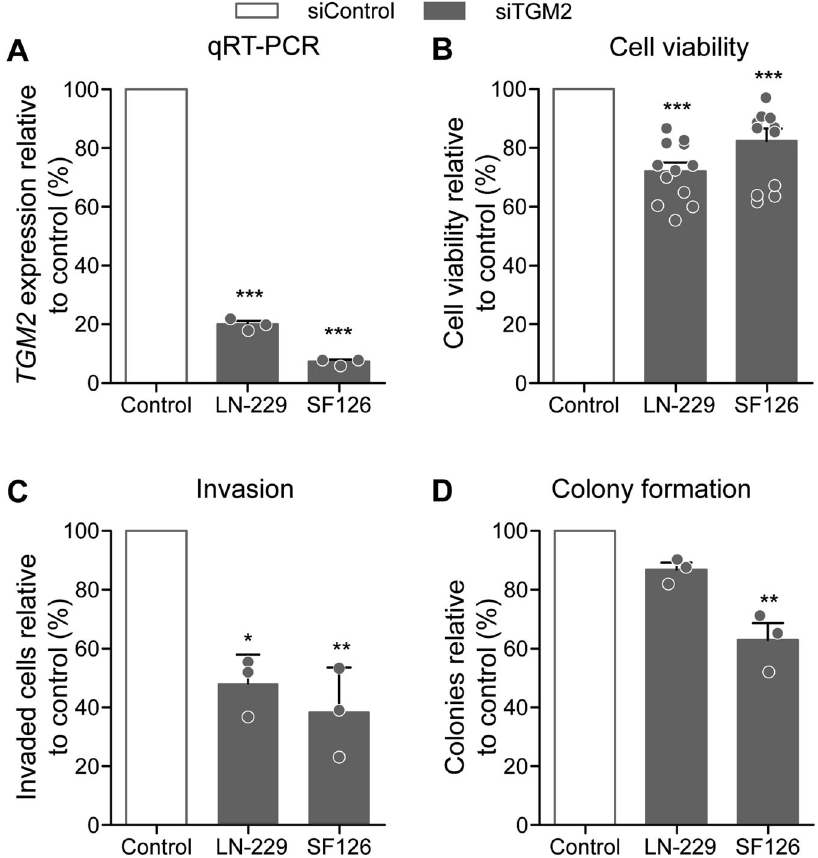
Fig. 6 TGM2 knock-down decreases oncogenic features in glioblastoma cell lines. A qRT-PCR analysis con fi rms siRNA-mediated knock- down of TGM2 in LN-229 and SF126 glioma cells. Shown are TGM2 mRNA levels normalized to PGK1 mRNA levels relative to control transfected cells set to 100%. Results of determination of cell viability using CellTiter-Glo assays ( B ), cell invasion using Boyden chamber assays ( C ), and colony formation propensity using colony formation assays ( D ) in control versus stable HOTAIRM1 knock-down LN-229 and SF126 cell lines. White bars represent control cells normalized to 100%, fi lled bars represent TGM2 knock-down cells. Two-way ANOVA was used for statistical analyses; mean ± SEM, *** p < 0.001, ** p < 0.01. n =